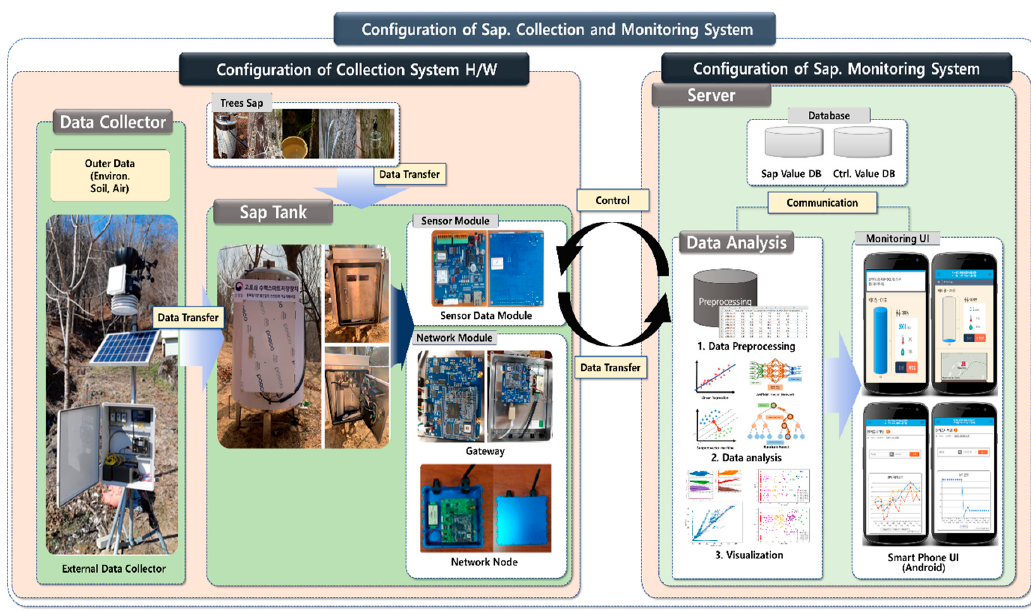
Figure 1. Overall block diagram of proposed system.